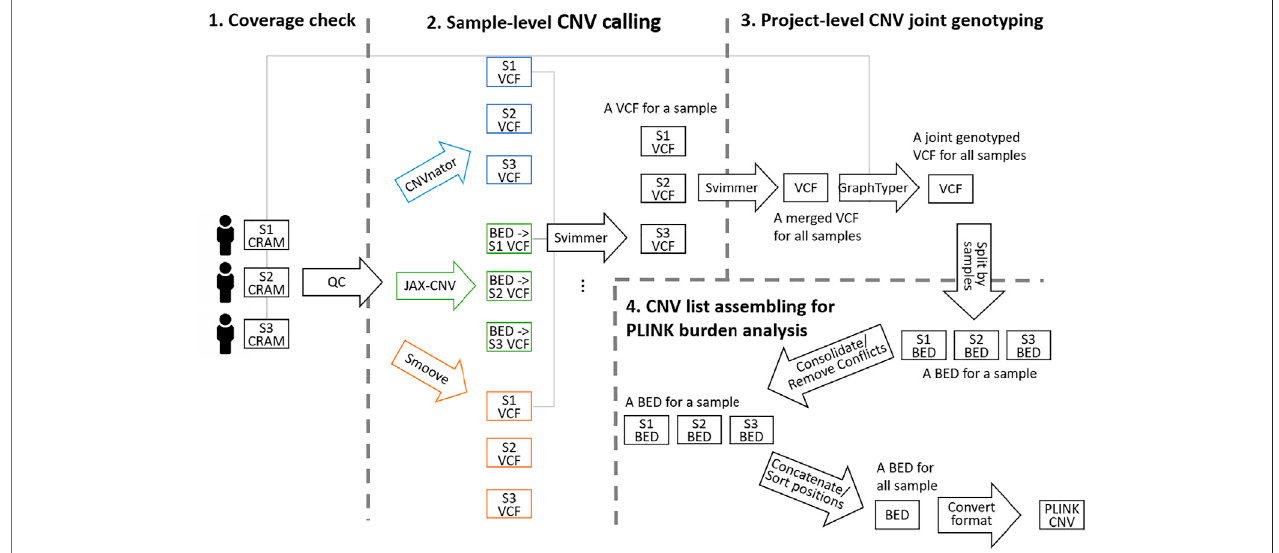
FIGURE 1 | Overview of the CNV identi fi cation work fl ow from WGS data consisting of the four steps. 1) Alignment coverage check. 2) Sample-level CNV calling including calling by CNVnator, JAX-CNV and Smoove, and merging the three callsets by Svimmer. Since Svimmer takes the VCF format as input, results of JAX-CNV in theBEDformatwereconvertedtotheVCFformat. 3) Project-levelCNVre-genotyping. 4) CNVlistassemblingforPLINKburdenanalysis.Theillustratedthreesamplesin the fi gure are notated by S1, S2 and S3 while 3,800 samples were processed in the study.